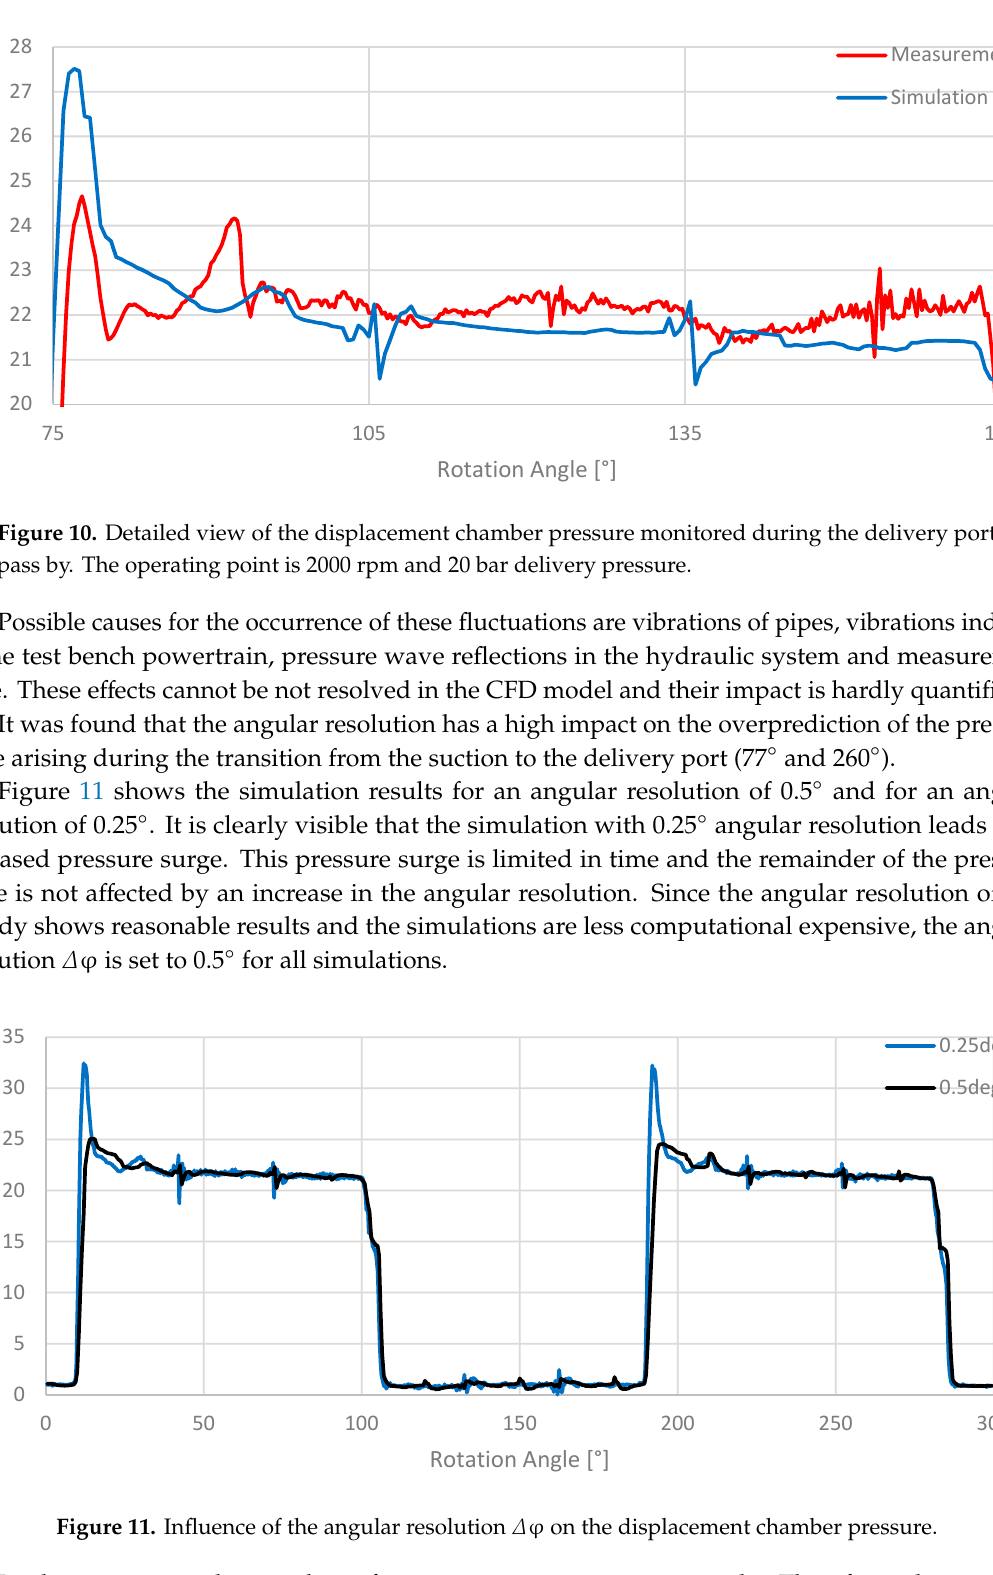
Figure 11. Influence of the angular resolution Δφ on the displacement chamber pressure.